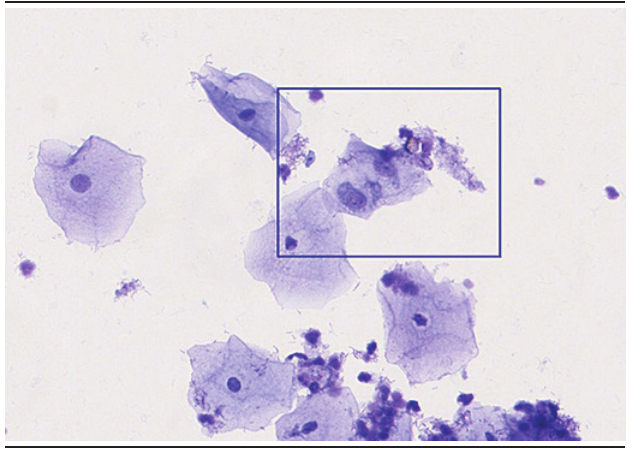
figurE 2 − Papanicolaou method, 100× LSIL: low-grade squamous intraepithelial